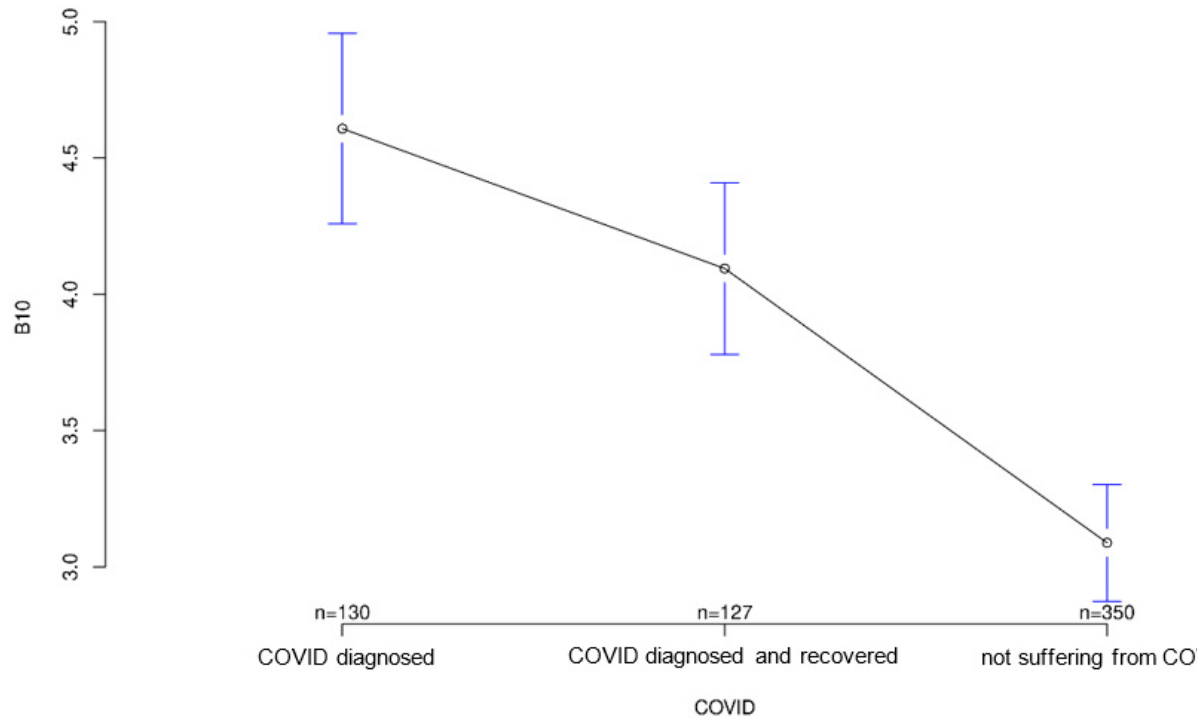
Figure 12. Average response to question 10 of the COVID-specific questionnaire: “Has your attitude toward outpatient medical technology changed since the COVID-19 pandemic?” The y -axis shows the mean result of participants choice on the Likert scale.